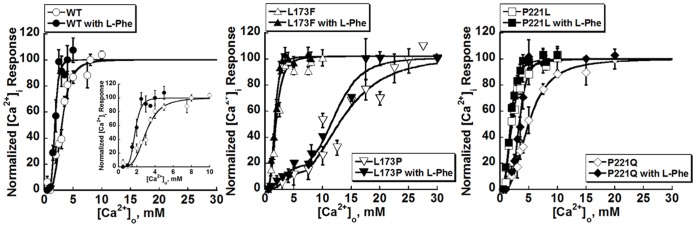
L-Phe modulates the [Ca2+]o concentration response curves in CaSR-transfected HEK293 cells.The [Ca2+]i responses of HEK293 cells transiently overexpressing WT CaSR or disease-related mutations were measured using Fura-2AM during stepwise increases in [Ca2+]o from 0.5 to 30 mM with or without L-Phe as above. The ratio of light emitted at 510 nm upon excitation alternately with 340 or 380 nm was normalized to the maximum response. And the average [Ca2+]i responses at various [Ca2+]o were normalized and plotted against [Ca2+]o and further fitted using the Hill equation. Open marker: in the absence of L-Phe; Closed marker: in the presence of 5 mM L-Phe.